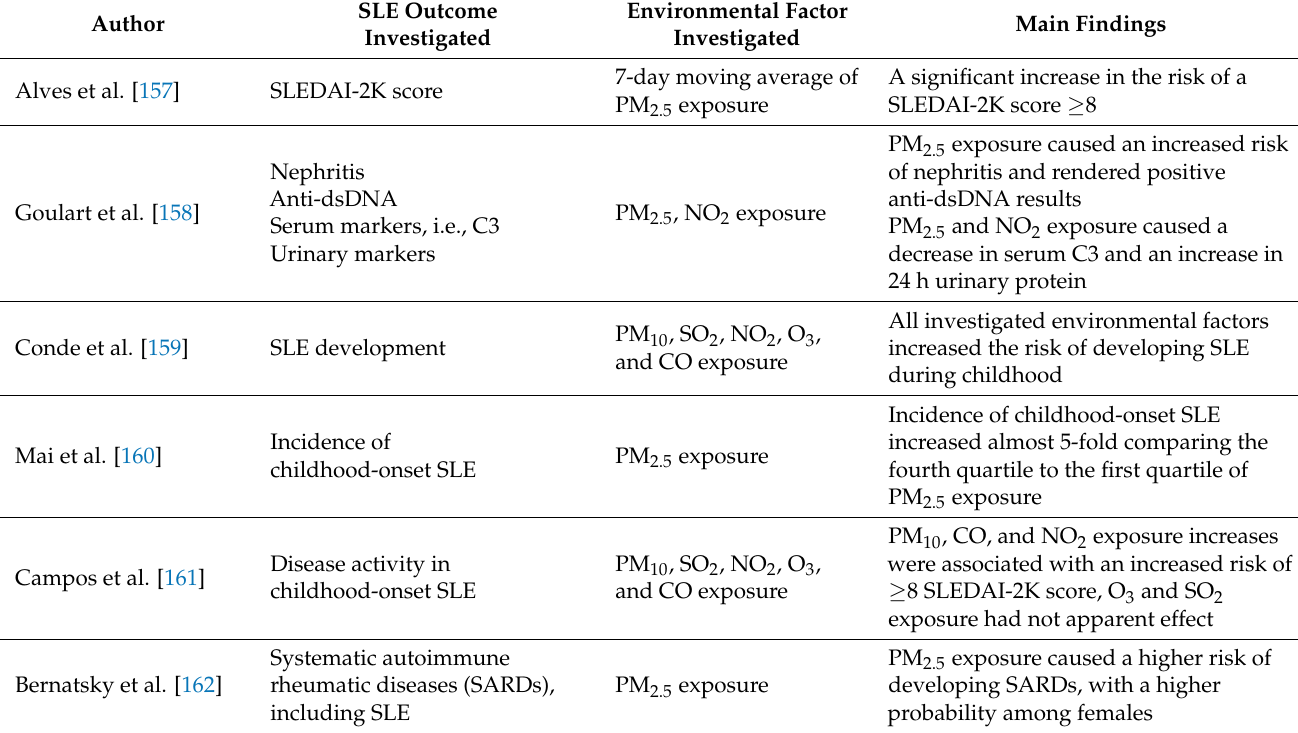
Table 2. Summary of Articles addressing the Effects of Air Pollution on